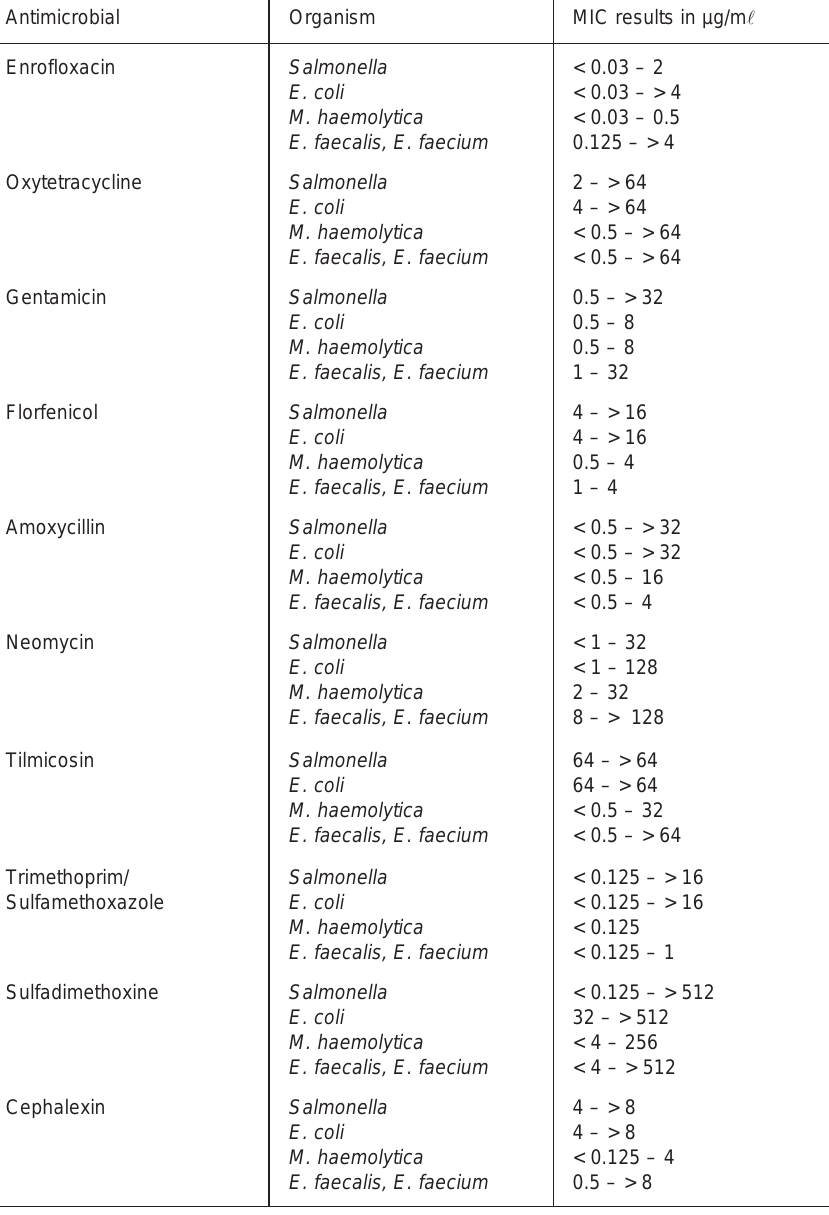
TABLE 1 Minimum Inhibitory Concentrations (MIC) recorded for antimicrobial drugs tested against the different isolates Antimicrobial